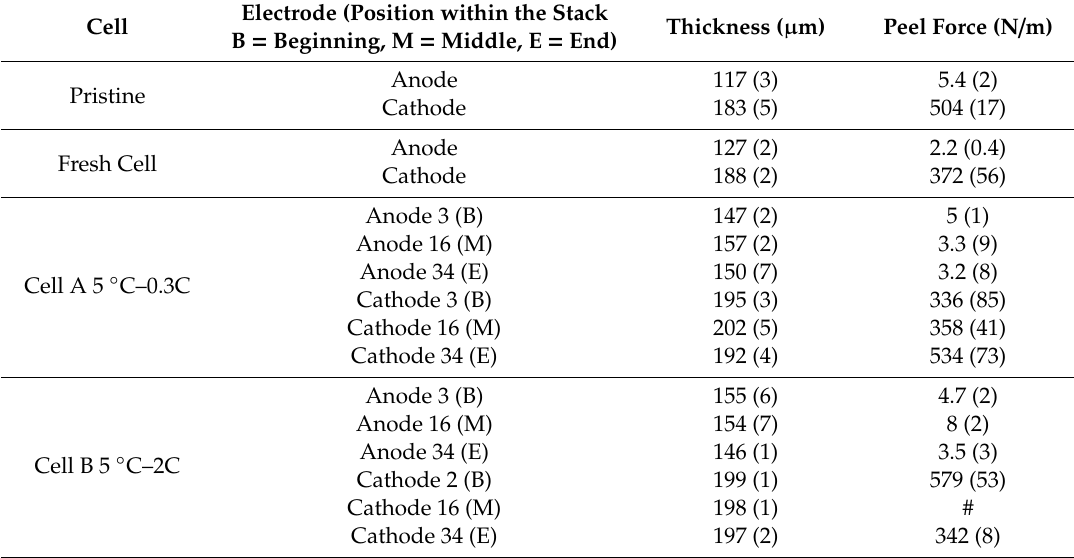
Table 3. Thickness and adhesion strength of pristine and aged electrode tapes. Results are provided as average of at least two tests per electrode sample with the standard deviation in brackets.